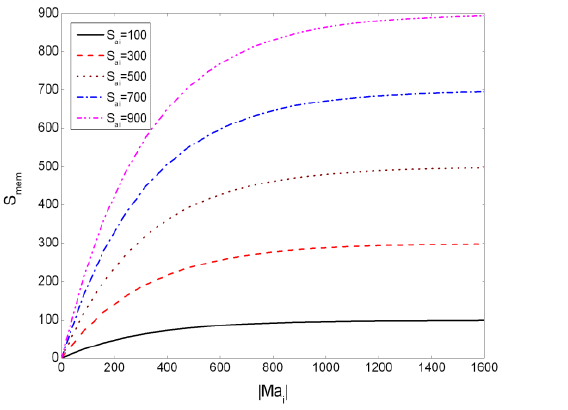
Fig. 4. The effect of S ai on S